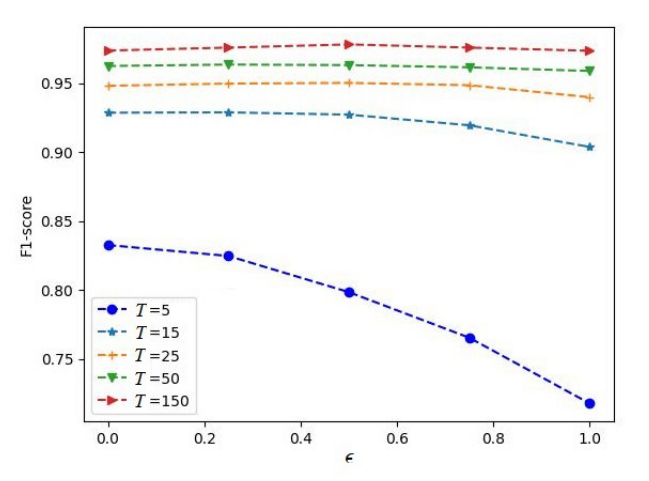
Figure 5. F1-score measures as functions of the contamination parameter (cid:101) for different numbers of trees in iForest T for the Circle dataset.